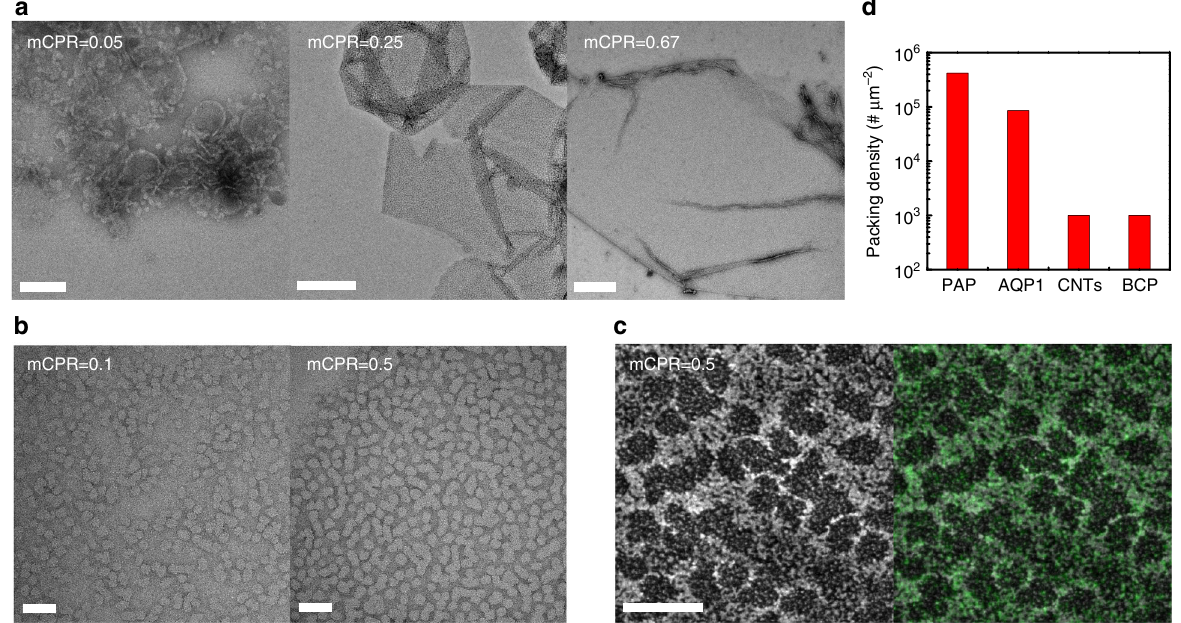
Fig. 4 PAP concentration in fl uences the morphology of self-assembled PAP-BCP aggregates and PAP channels segregate into rafts. a Negative-stain TEM images show the representative morphologies of aggregates formed at different molar channel-to-polymer ratios (mCPRs). Increasing mCPRs from 0.05, 0.25 to 0.67 resulted in morphology transitions from small vesicles to large vesicles, and fi nally to fl at membranes. Scale bars, 0.1 μ m, 0.5 μ m, and 1 μ m, from left to right, respectively. b TEM images at high magni fi cation show the microphase separation in PB12 membranes. Uranyl formate selectively stained PB-PEO. The brighter unstained microdomains of 20 – 30 nm are PAP channels and the density of these domains increased from low (left, mCPR = 0.1) to high (right, mCPR = 0.5) channel concentrations. c High-resolution scanning TEM (STEM) and energy dispersive spectroscopy (EDS) map supported the microphase separation hypothesis. The left is the high-angle annular dark- fi eld (HAADF) image. The right is the HAADF overlaid with uranyl map (green). The uranyl map aligned well with the PB polymer enriched region. Scale bar, 50 nm. d The packing density of PAP channels in PB12 membranes was ~4.2 × 10 5 μ m − 2 , more than two orders of magnitude higher that packing density of CNTs (0.1~2.5 × 10 3 μ m − 2 ) 44 – 46 and block copolymer templated nanopore membranes (~10 3 μ m − 2 ) 47 . Scale bar, 40 (Supplementary Fig. 21, inset, ~ 40% mobile fraction) with a larger diffusion coef fi cient of 0.086 μ m 2 s − 1 , and a long recovery (Supplementary Fig. 21, ~34% mobile fraction) with a smaller − 1 . The remaining 26% was diffusion coef fi cient of 0.0069 μ m 2 s